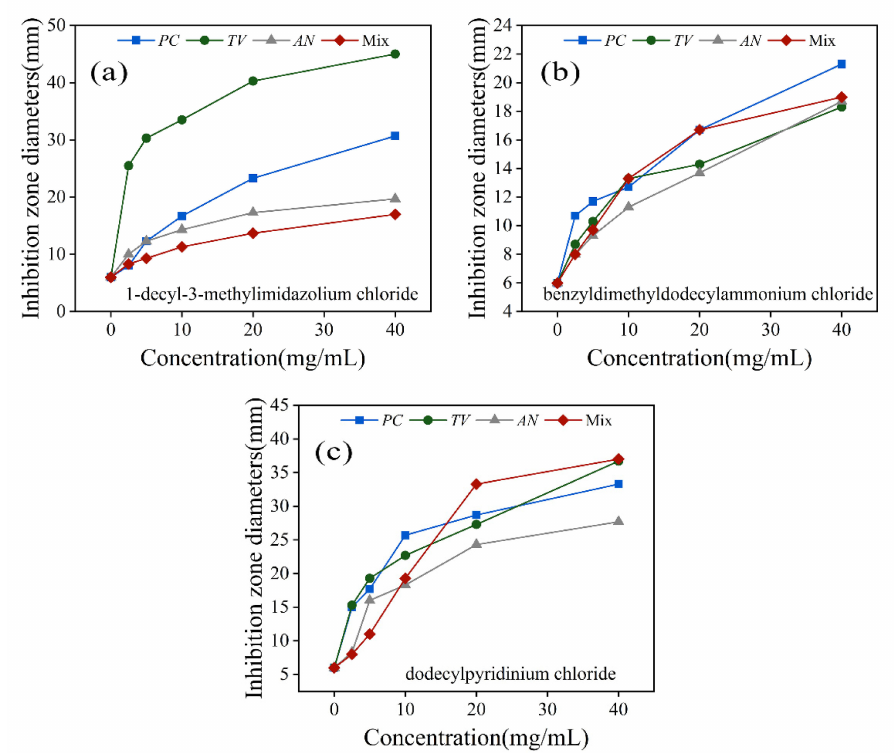
Figure 4. Inhibition zone diameters of three ionic liquids against PC , TV , AN , and Mix. ( a ) 1- decyl-3-methylimidazole chloride; ( b ) benzyldimethyldodecylammonium chloride; ( c ) dodecylpyri- dinium chloride.